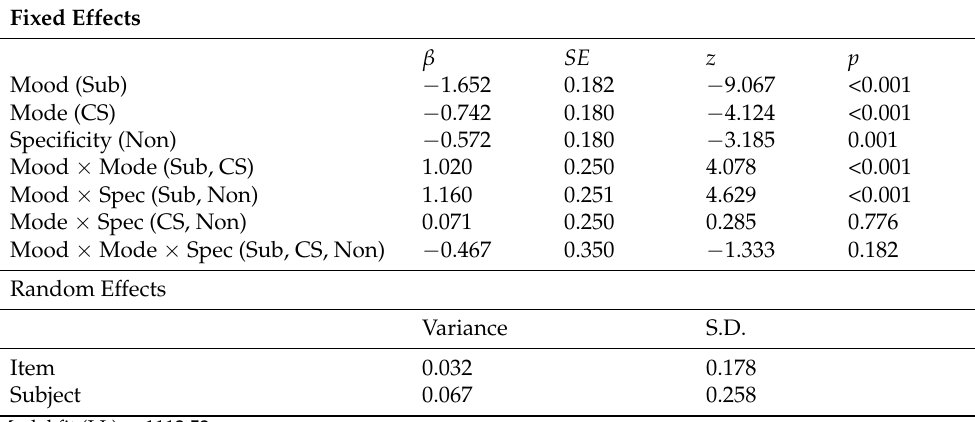
Figure 1. Mean ratings per condition with 95% confidence interval bars. Table 2. Final model of speaker ratings, without proficiency (reference level is Spanish-only, Indicative mood, Specific antecedents).